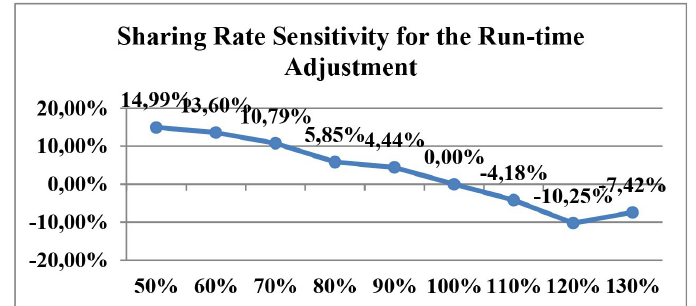
Figure 7. Sharing Rate Sensitivity Line Chart After Run-time